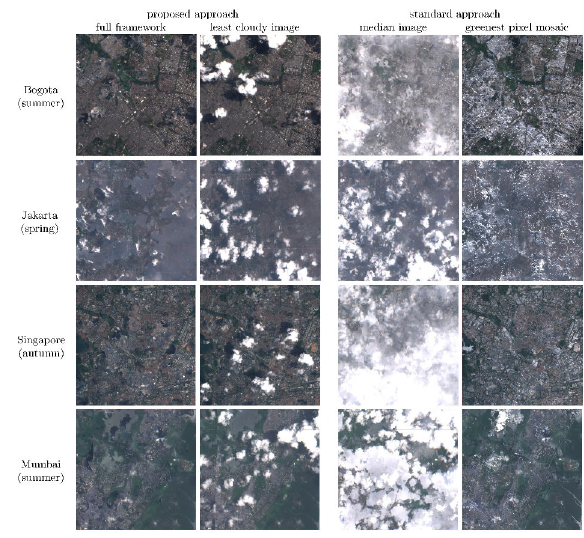
Figure 10. Cloud-free image aggregation examples for areas frequently affected by clouds.